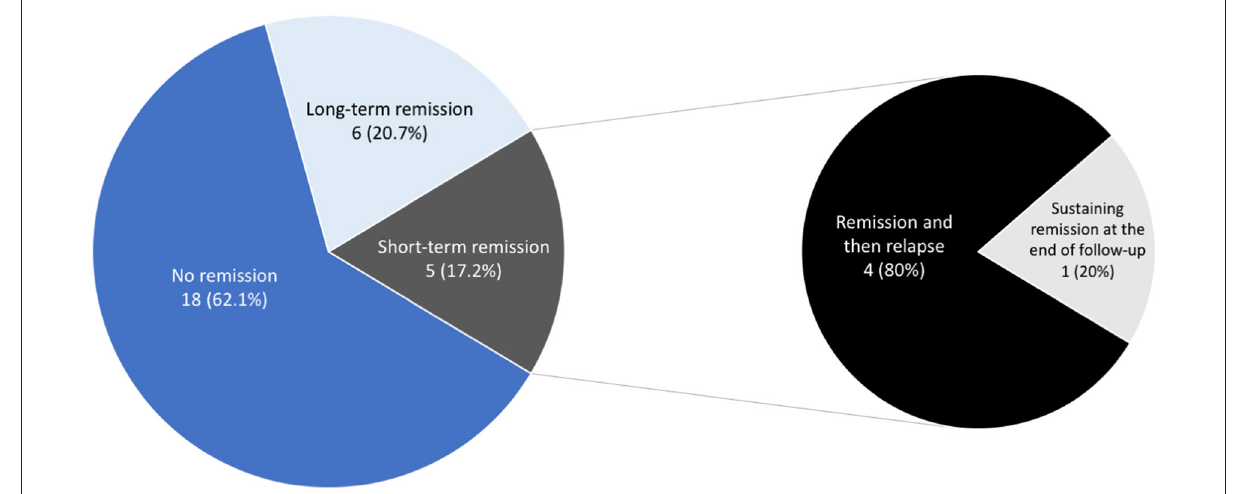
FIGURE2 Short-term and long-term remission off medication.